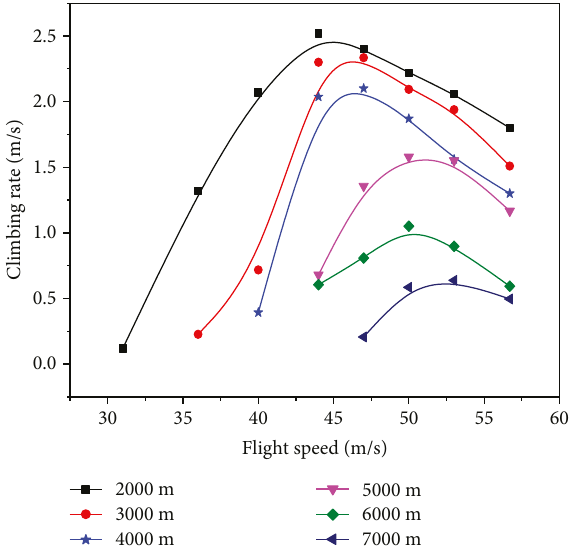
Figure 14: Climbing rates of UAV at di ff erent altitudes.